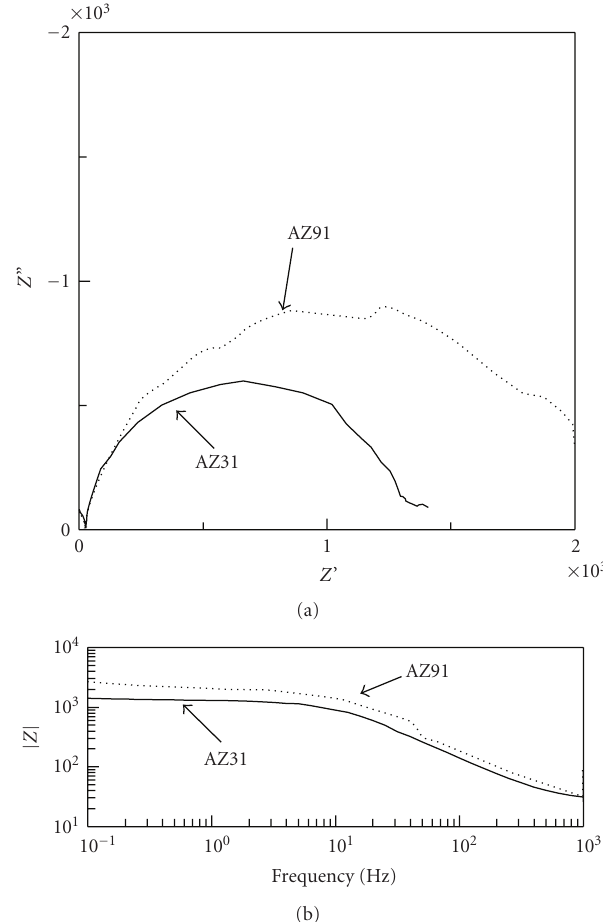
Figure 6: Impedance diagrams of AZ31 and AZ91 magnesium alloys in 17 mMNaCl and 0.1MNa 2 SO 4 solution. occurring small fluctuations of the temperature or pH.